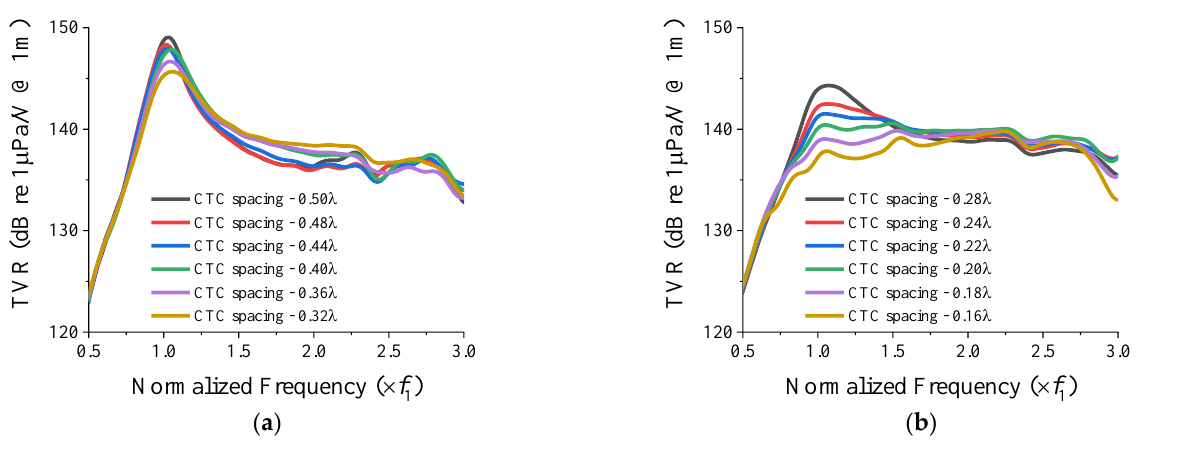
Figure 5. Effect of CTC spacing on the TVR spectrum of the 3 × 3 two-layered array: ( a ) for CTC spacing from 0.50 λ to 0.32 λ ; ( b ) for CTC spacing from 0.28 λ to 0.16 λ .